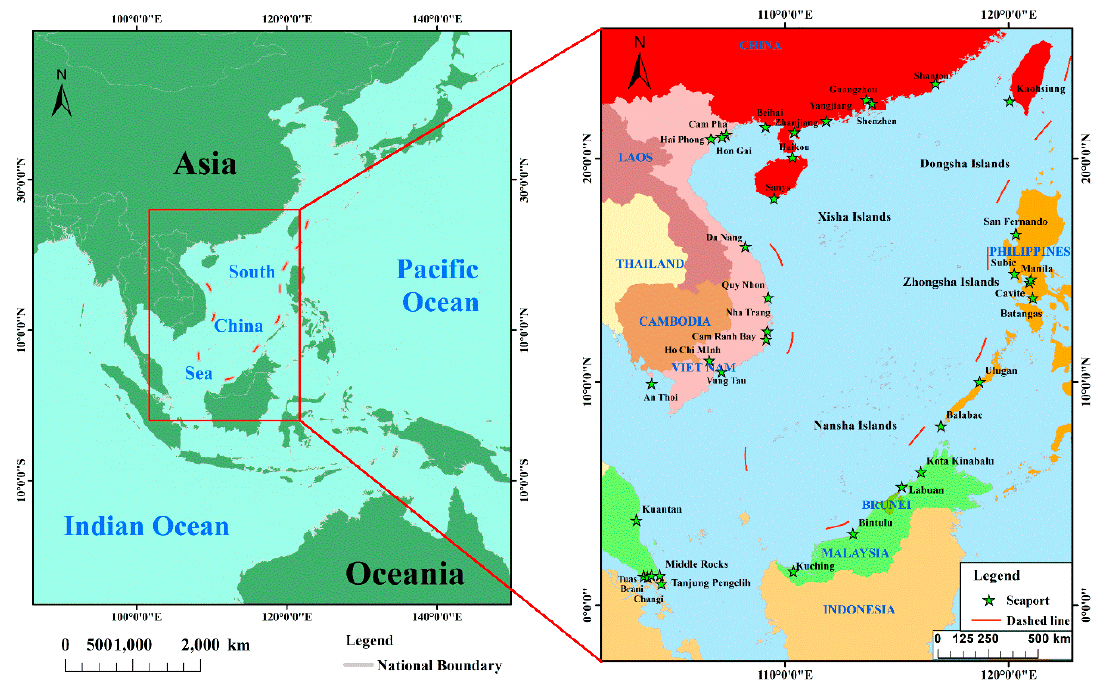
Figure 4. Location of the South China Sea (SCS), and distribution of seaports around the SCS.